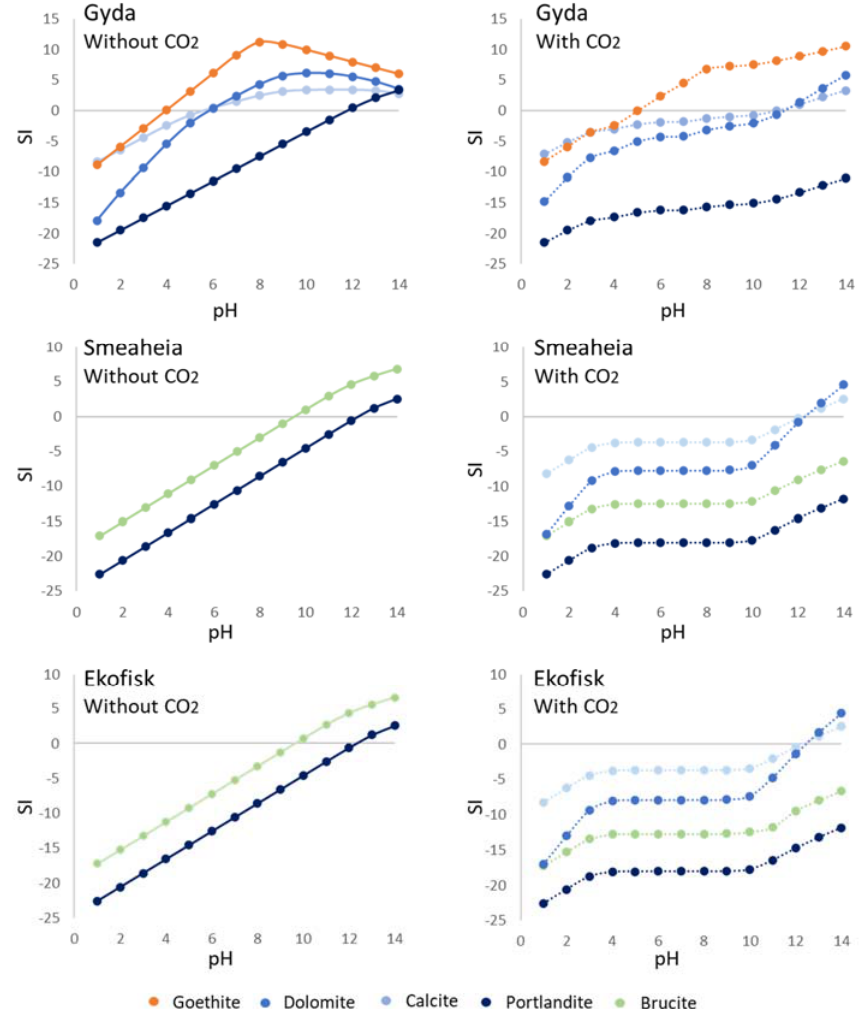
Figure 2. Modelled saturation indices (SI) for Gyda, Smeaheia and Ekofisk formation waters at 23 °C and 1 atm for different pH values, without ( left ) and with ( right ) additional CO 2 .